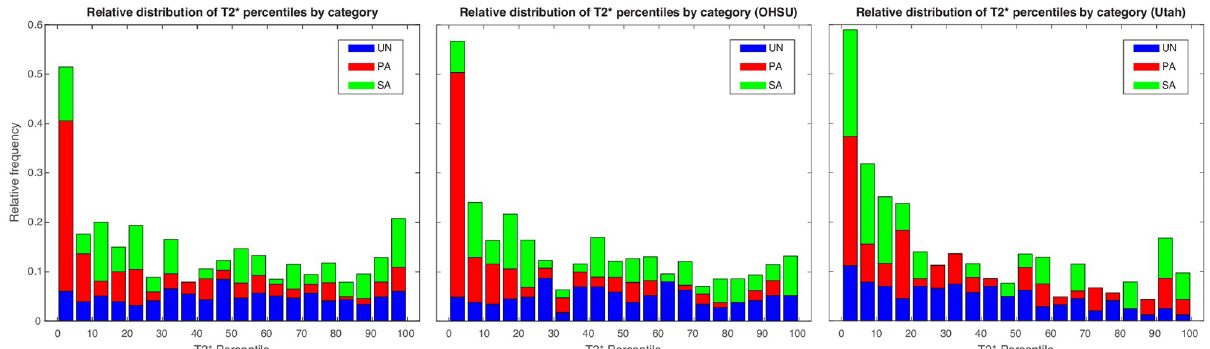
Fig 4. Histograms of T2 � percentiles. Bar charts showing histograms of measured T2 � percentiles for uncomplicated normal (UN, blue), primary adverse (PA, red), and secondary abnormal (SA, green) pregnancies for both sites (left) and for OHSU (middle) and Utah (right) separately.